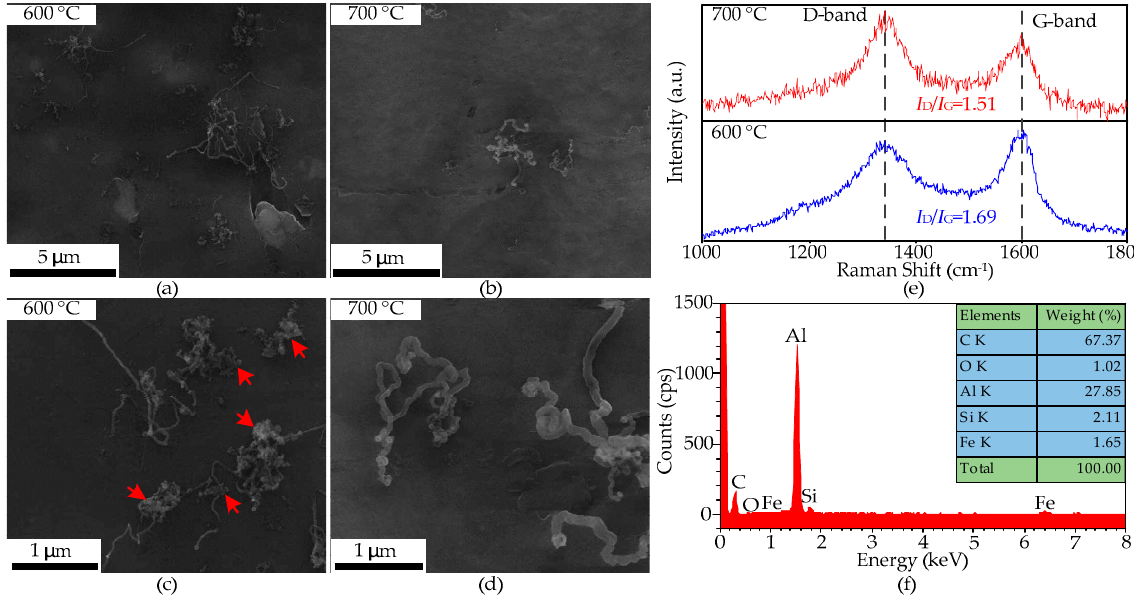
Figure 9. The SEM micrographs and Raman spectra of the CNTs obtained at 600 and 700 °C on the aluminum foil treated by HCl. ( a , b ): low-magnification images; ( c , d ): high-magnification images; ( e ): Raman spectra of the CNTs; ( f ): EDS spectra of the CNTs at 600 °C.